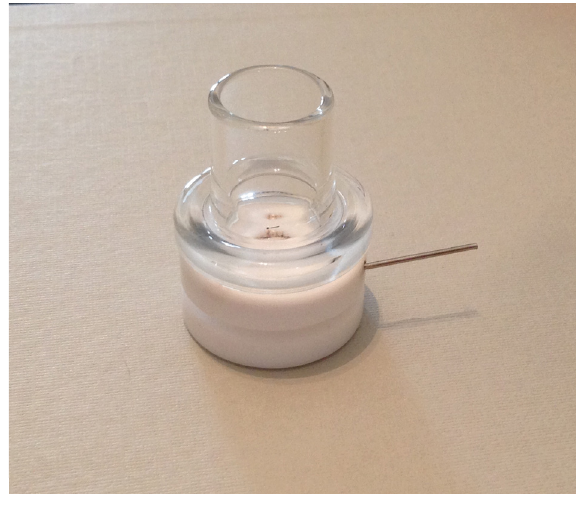
Figure 2. Glass apparatus placed over the acrylic apparatus, where 2 g of the formulation was added. At the side of the acrilic apparatus, there was an orifice, where the silver wire was placed, getting into contact with the side of the dental block.